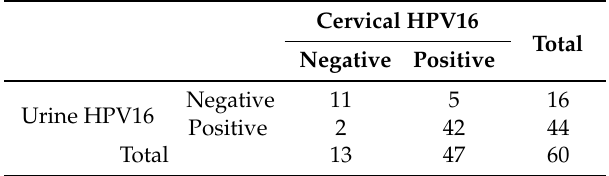
Table 2. Urine HPV16 versus cervical HPV16 positivity. κ : 0.683, p < 0.001.